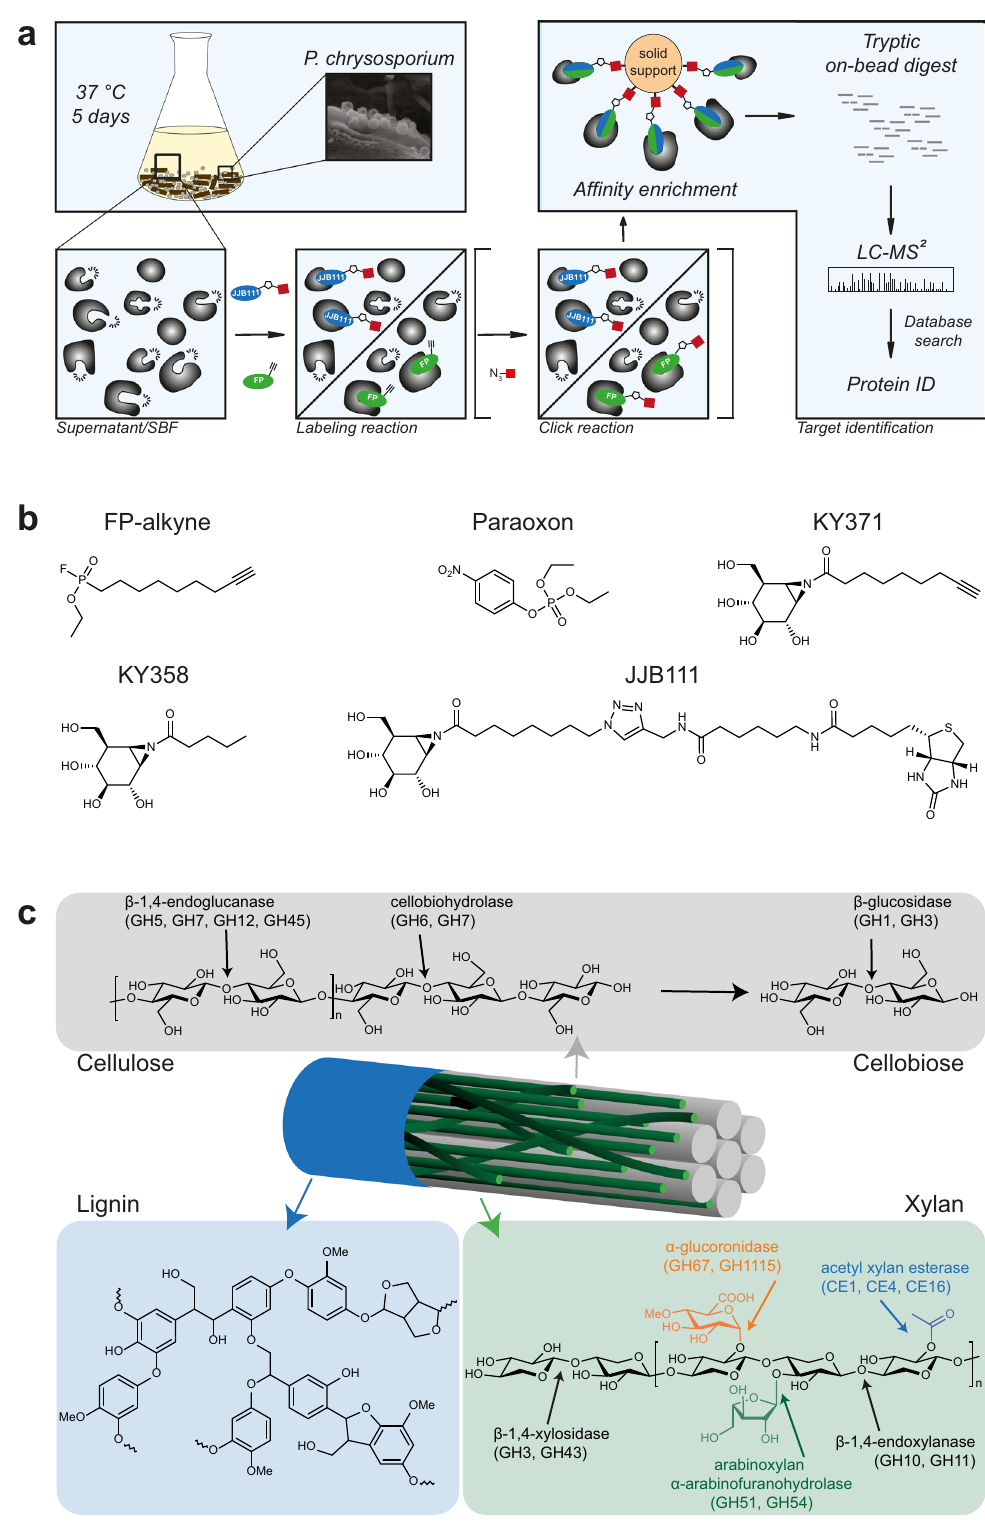
For the FP-alkyne treatment, this approach led to the identi fi cation of two SHs with the Joint Genome Institute (JGI) protein ID Phchr2|126075 (predicted carbohydrate esterase family 1 (CE1) with a CBM1 domain, MW of 35.6 kDa) and Phchr2|2912243 (predicted carbohydrate esterase family 15 (CE15), MW of 44.3 kDa) (Table 1 and green-labeled proteins in Fig. 2b; see Supplementary Data 1 for the complete list of